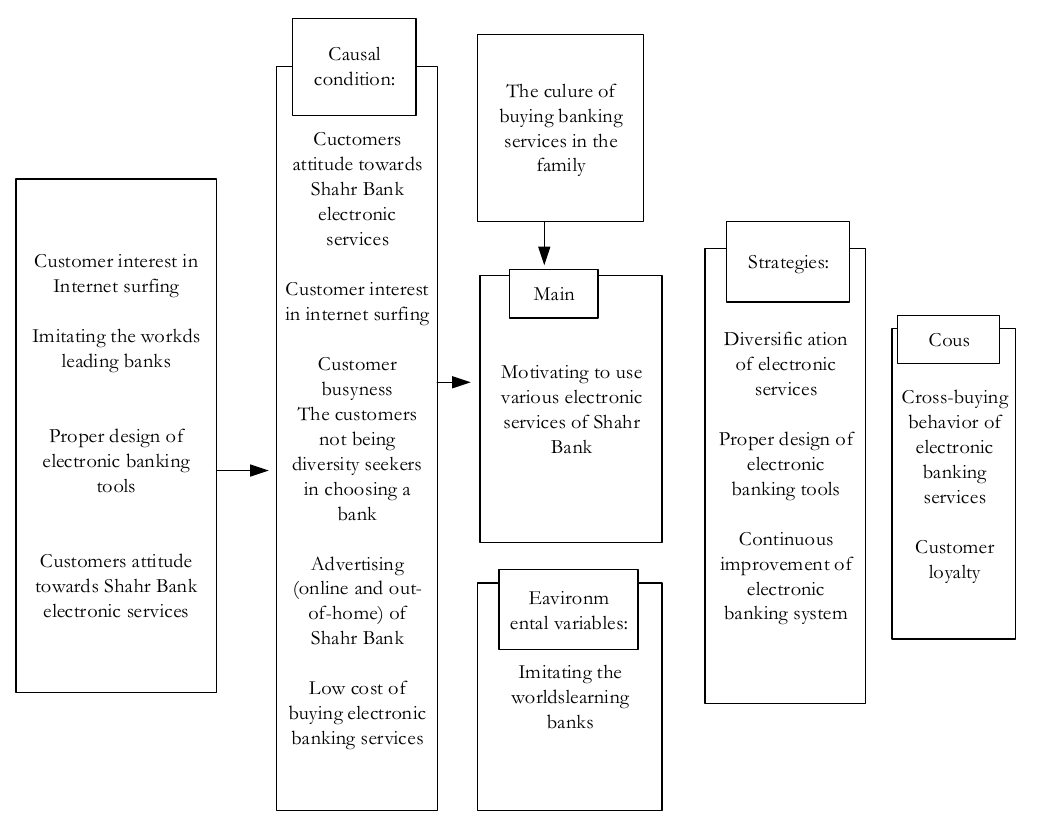
Fig . 2 . Placement of categories in the structure of the paradigm